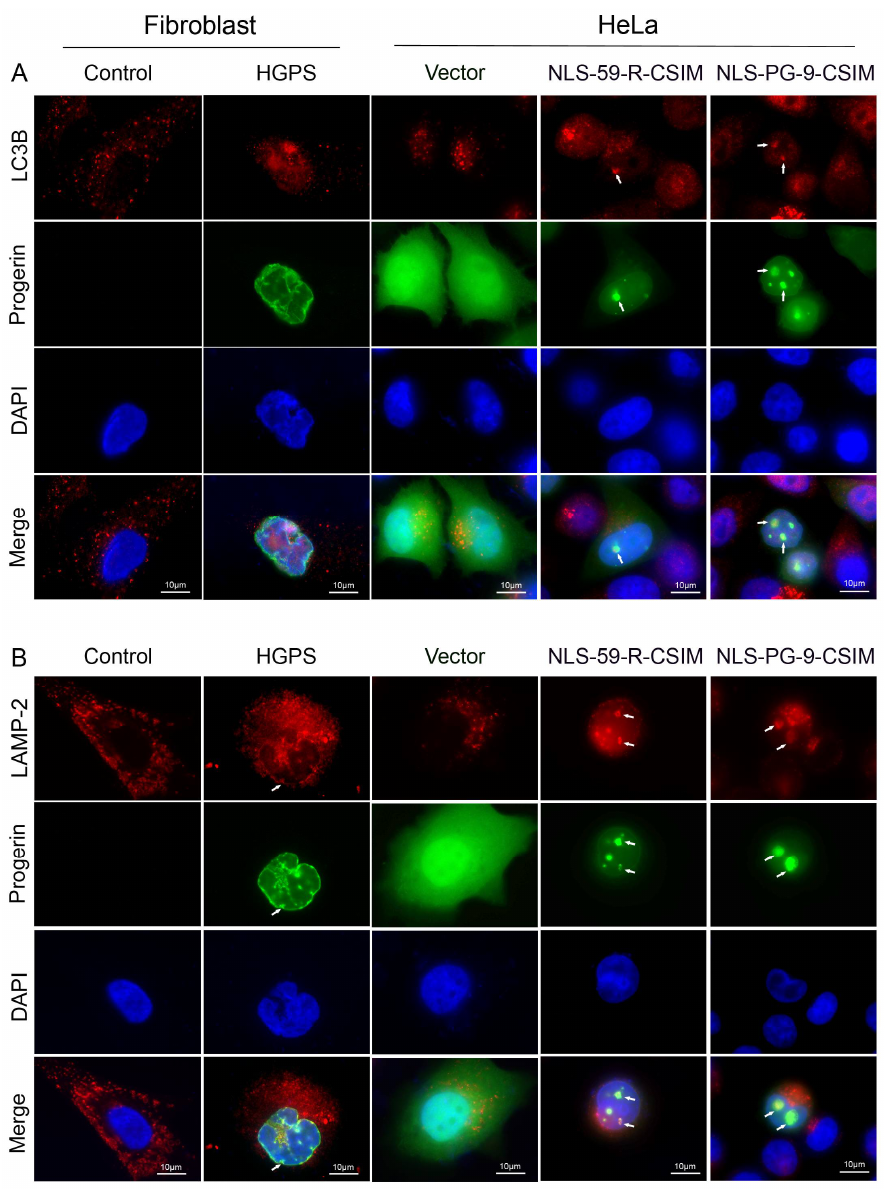
Figure 5. Detection of autophagosome and lysosome distributions. ( A ) LC3B and ( B ) LAMP-2 were used as markers to detect autophagosomes and lysosomes, respectively. Chromatin was stained with DAPI. Representative images of LC3B and LAMP-2 staining in normal and Hutchinson–Gilford progeria syndrome (HGPS) fibroblasts and EGFP vector-, EGFP–NLS-59-R-CSIM-, and EGFP–NLS- PG-9-CSIM-transfected cells. Redistribution and colocalization patterns of LC3B and LAMP-2 in the NE and NE invaginations are shown in HGPS fibroblasts and EGFP–NLS-59-R-CSIM- and EGFP– NLS-PG-9-CSIM-transfected cells, as indicated with arrowheads. Scale bar, 10 μm.